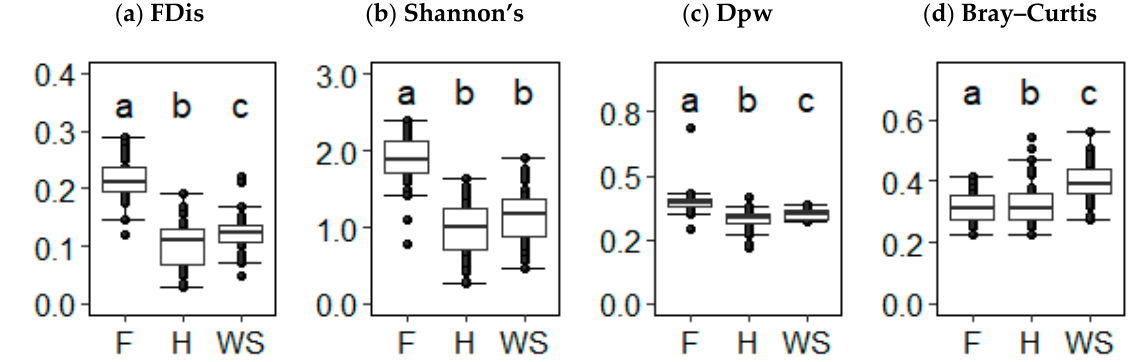
Figure 3. ( a ) Functional alpha diversity (functional dispersion), ( b ) taxonomic alpha diversity (Shannon’s diversity), ( c ) functional beta diversity (functional pairwise dissimilarity), and ( d ) taxonomic beta diversity (Bray–Curtis dissimilarity) values for all life forms (overall) in forest (F) ( n = 40), heath (H) ( n = 45), and wood savannah (WS) ( n = 45) alternate states. Unlike letters above the error bars indicate significant differences at p < 0.05.